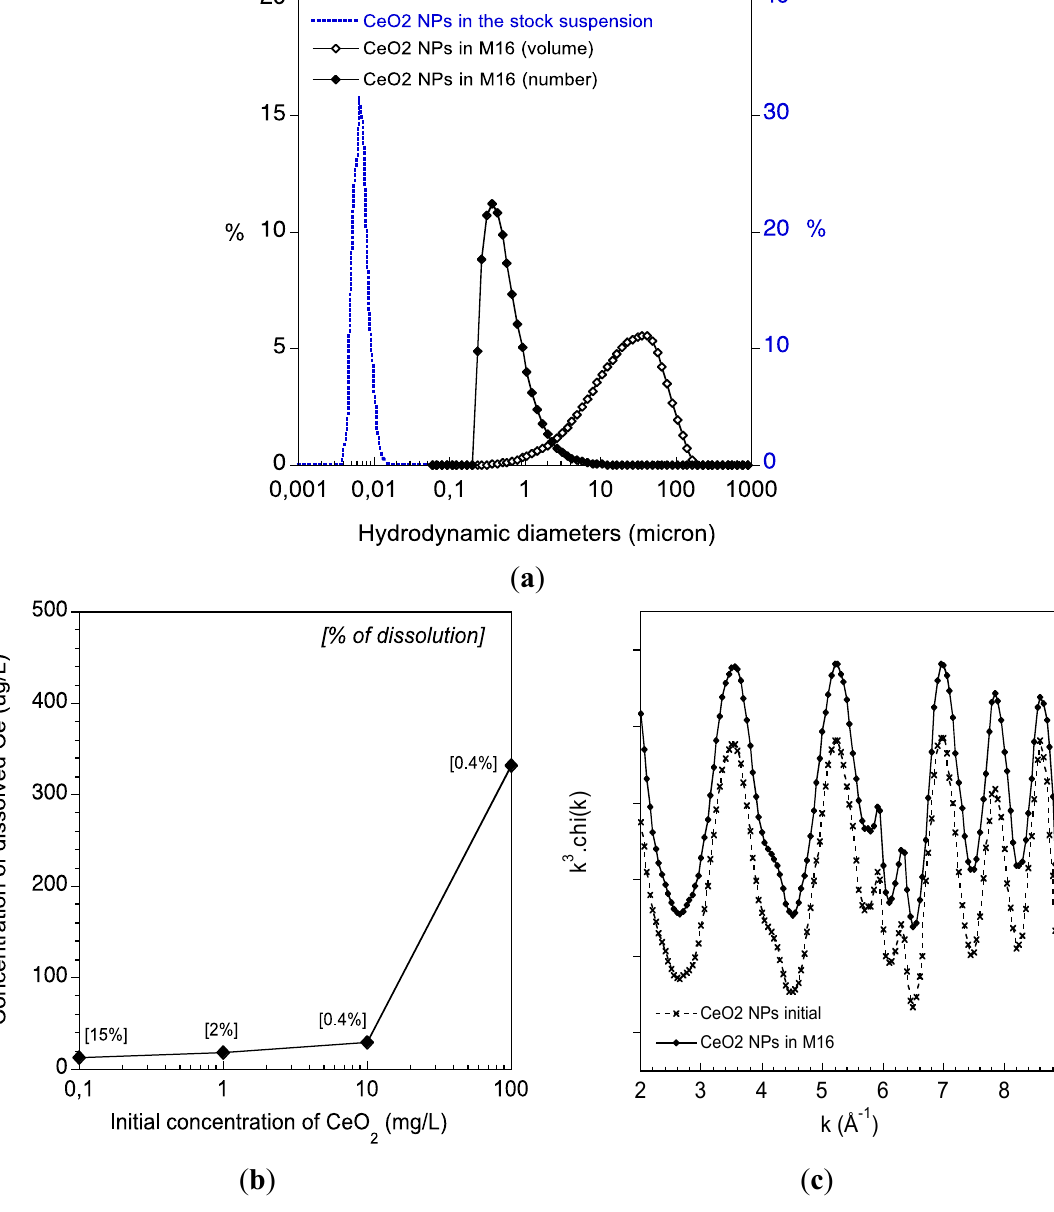
Figure 1. ( a ) Aggregation stage of the C hydrodynamic diameters of the C M16 medium (expressed as a volume or number distribution); ( b ) Chemical stability of the C O ENPs in M16. Dissolution of C e 2 ICP-MS; ( c ) Structural stability of the C C O ENPs before and after 2 h of incubation within the abiotic M16 e 2